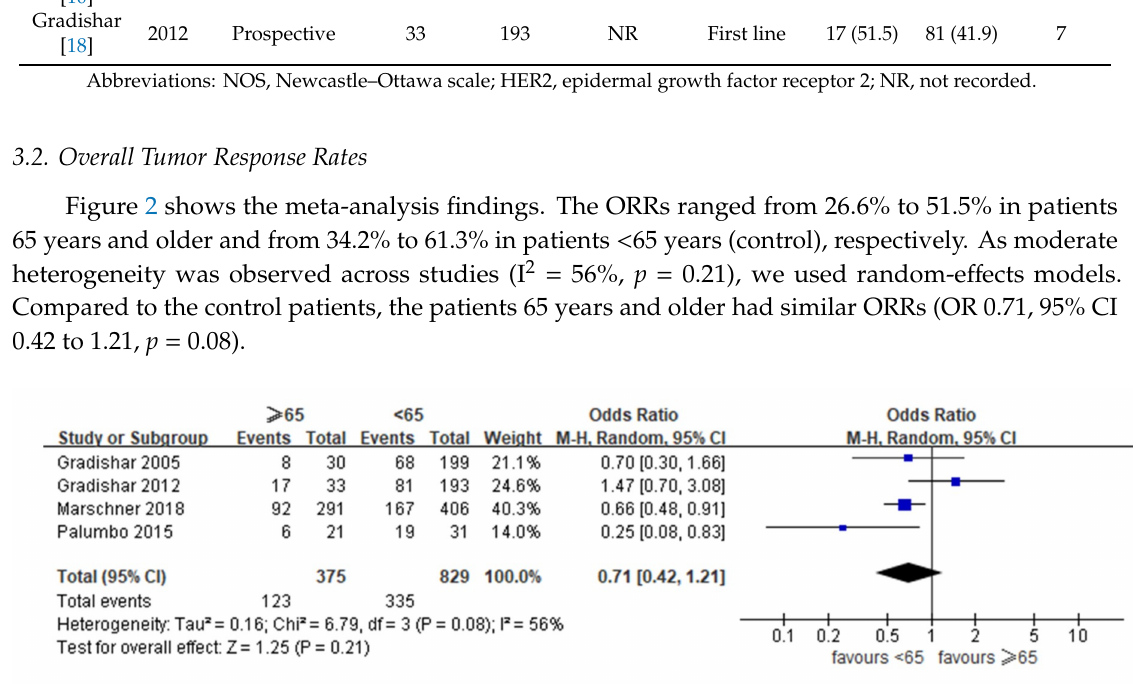
Figure 2. Forest plot of the included studies assessing di ff erences in overall response rates between patients ≥ 65 years and patients under 65